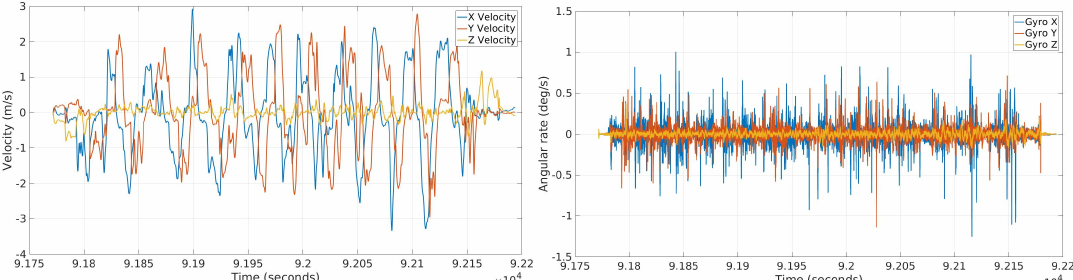
Figure 9. Dynamics of one of the UAVs in the experiment. The velocity is shown on the left and angular rates along three directions are shown on the